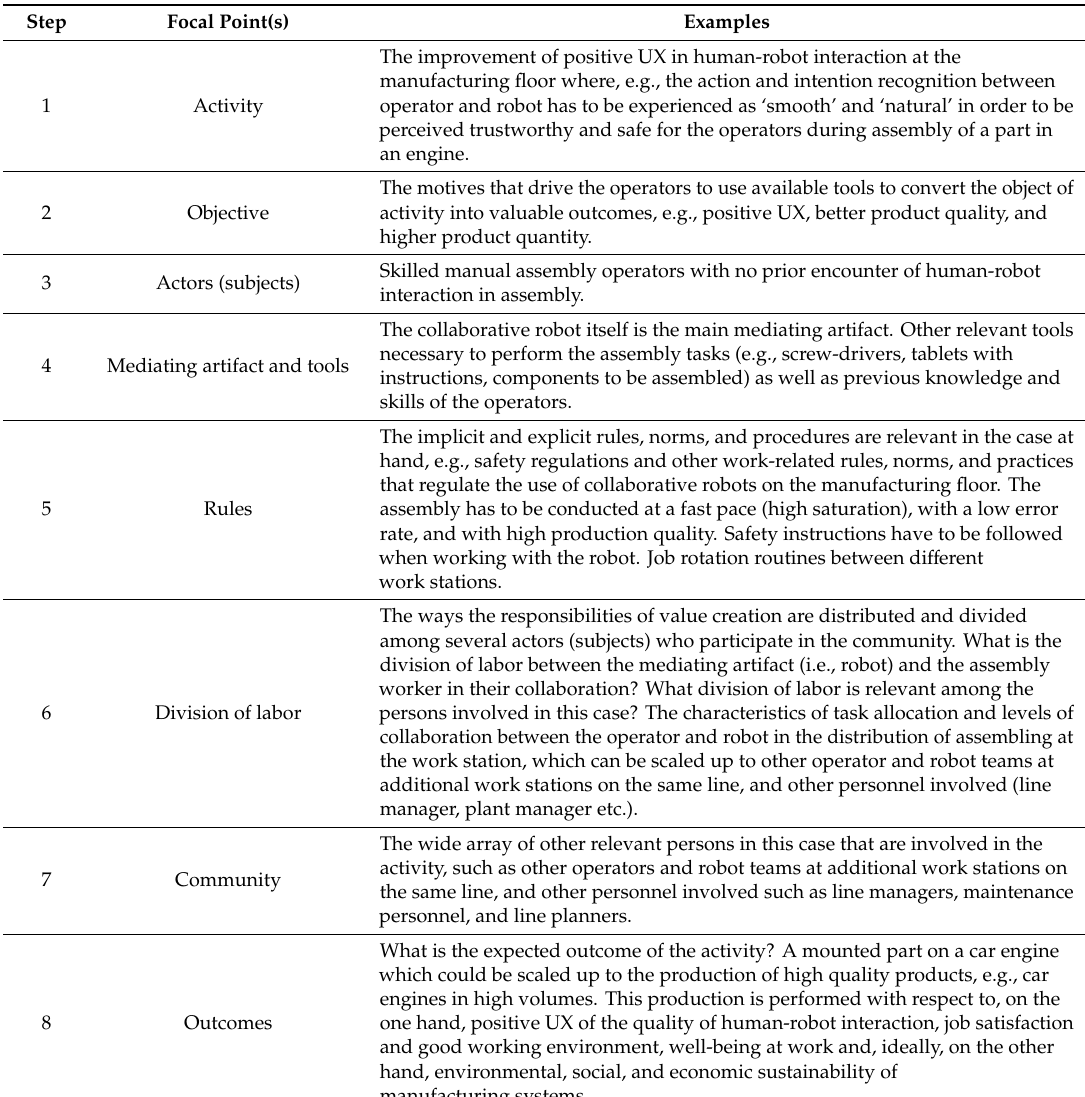
Table 2. Focal points to consider during the analysis of the human-robot interaction situated within the context of interest to identify UX problems and tentatively gain a better understanding of why they occurred, which here are portrayed in the context of human-robot interaction in assembly (adapted from